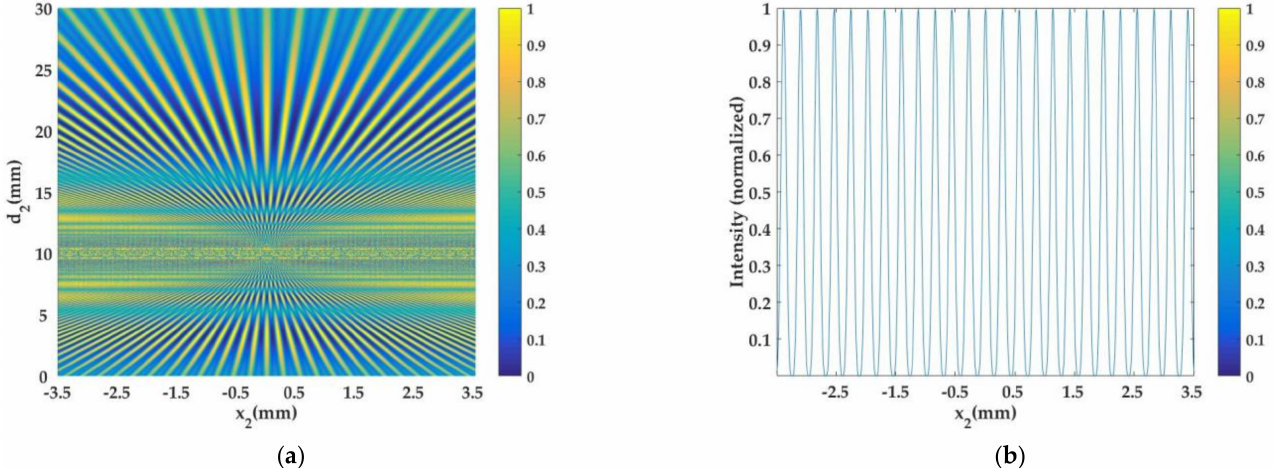
Figure 11. Simulated ( a ) intensity carpet (with λ = 0.6328 µ m, p 1 = 0.2822 mm, f = 100 mm) and ( b ) the intensity profiles at d 2 = 200